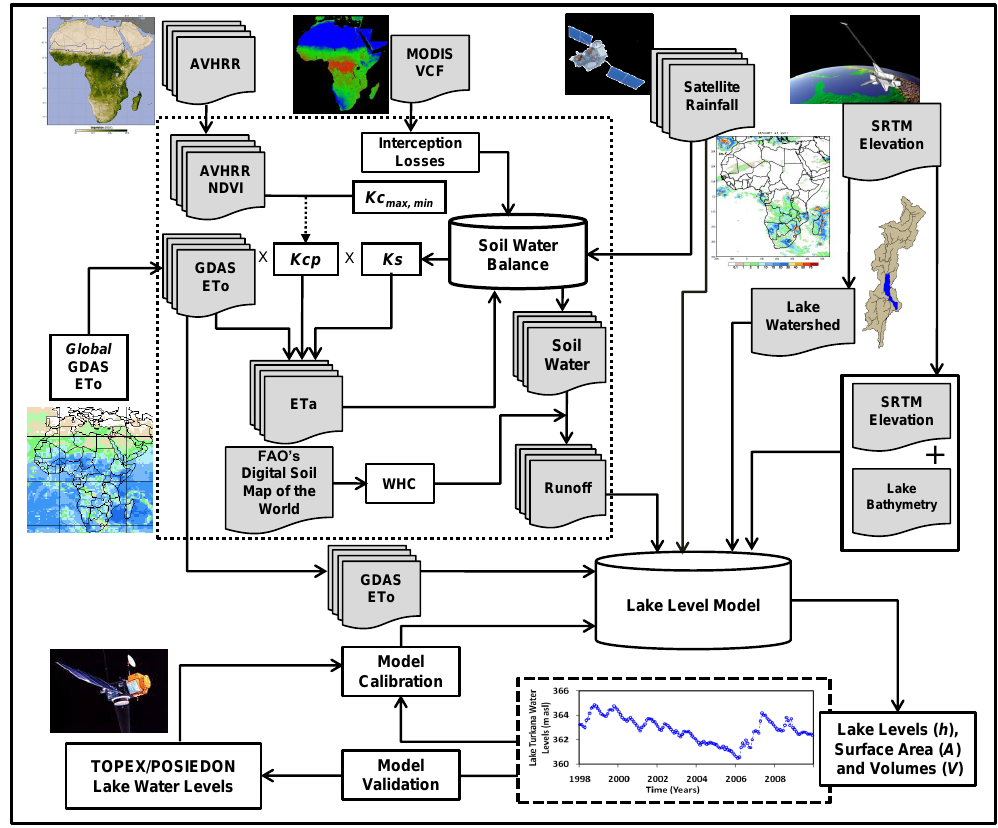
Fig. 2. Flowchart showing the lake level modelling (LLM) approach using multi-source satellite data.